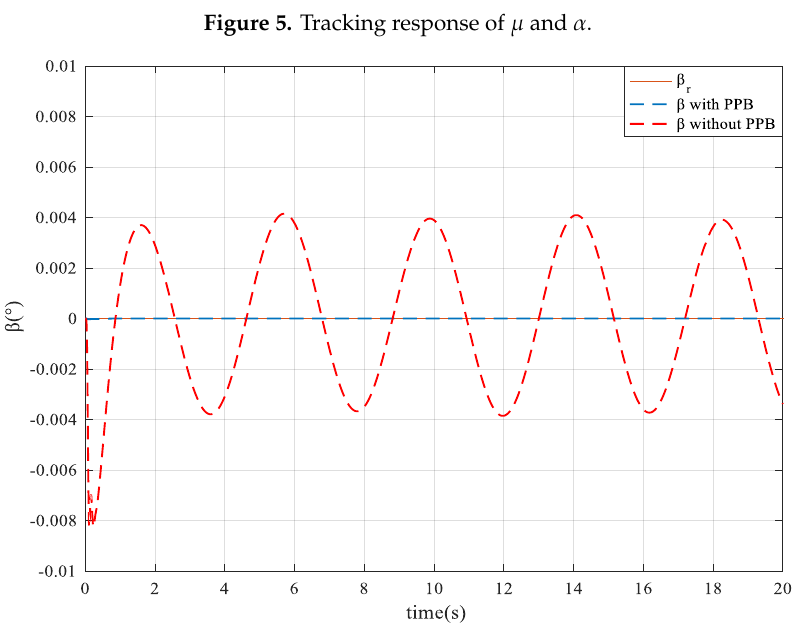
Figure 5. Tracking response of µ and α . Actuators 2020 , 9 , x FOR PEER REVIEW